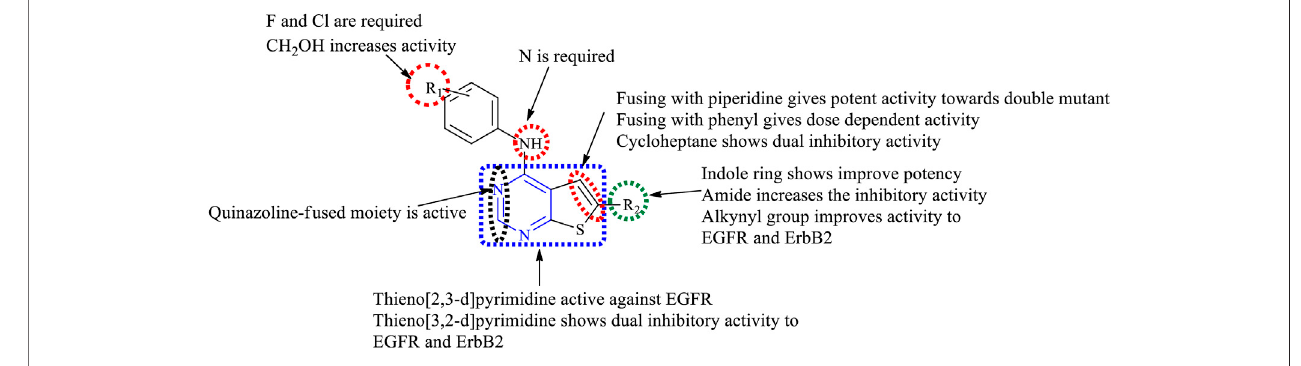
FIGURE 14 | Summary SAR of